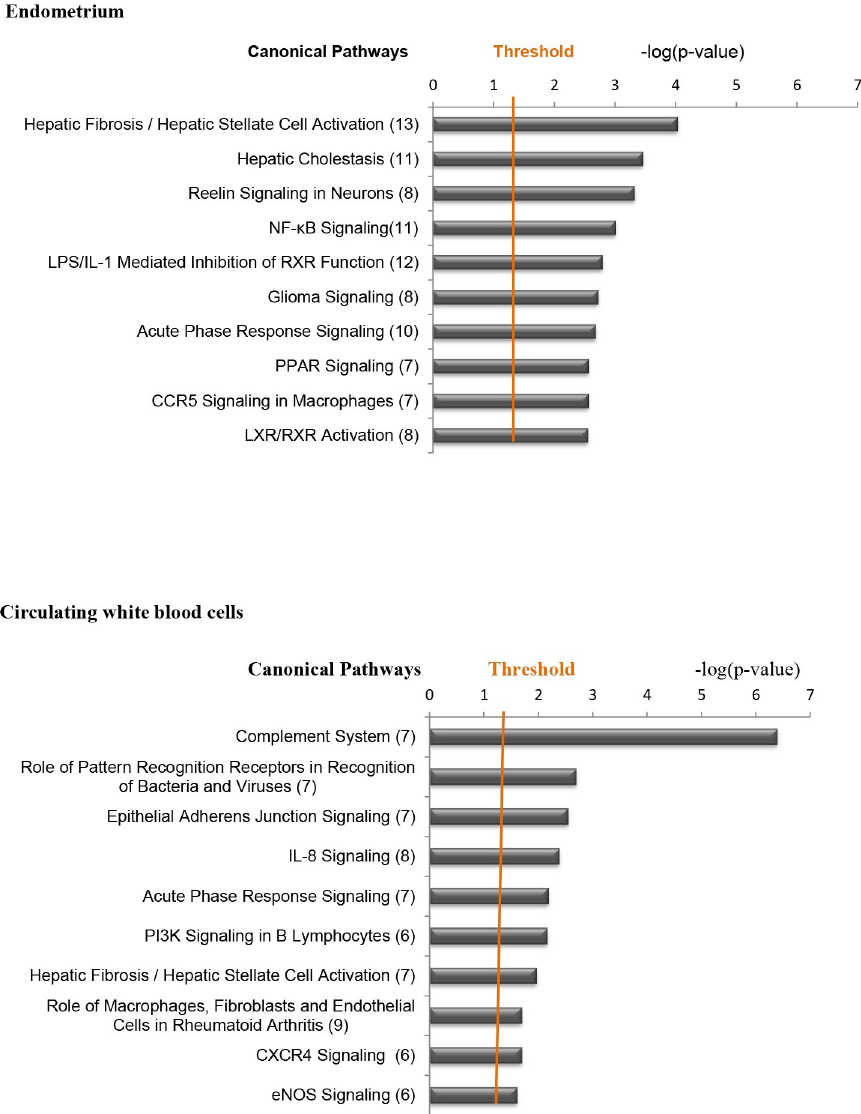
Fig 3. Canonical pathways analysis of differentially expressed genes in cows with subclinical endometritis compared with healthy dairy Holstein cows at 45–55 days postpartum. Ingenuity Pathway Analysis (IPA) was run to determin e canonical pathways altered in endometrial biopsies and in white circulating blood cells of cows with subclinical endometritis (SCE, n = 4 including follicular phase, n = 1; luteal phase, n = 3) compared with healthy cows (n = 4 including follicular phase, n = 2; luteal phase, n = 2) at 45–55 days postpartum (DPP). The top-10 canonical pathways are presented with the number of molecules indicated in brackets. P s were significant (p < 0.05) for random datasets calculated using Fisher’s exact test. Threshold criteria considered for the analysis are -log(p-value) > 1.3. The list of genes under each category is provided in S2 Table. Analysis of selected genes by quantitative real time PCR. To validate the microarray analyses in the endometrium, a selection of genes differentially expressed between SCE (n = 3) and healthy (n = 10) cows was quantified by real time PCR (RT-qPCR). Expression of C2 , C3 and PF4 , transcripts was significantly higher (p � 0.05) in the SCE cows than in the healthy females (Fig 5). In the “healthy” group, when the stage of estrous cycle was considered (follicular phase; n = 5 cows; luteal phase; n = 5 cows), RT-qPCR analysis showed that the